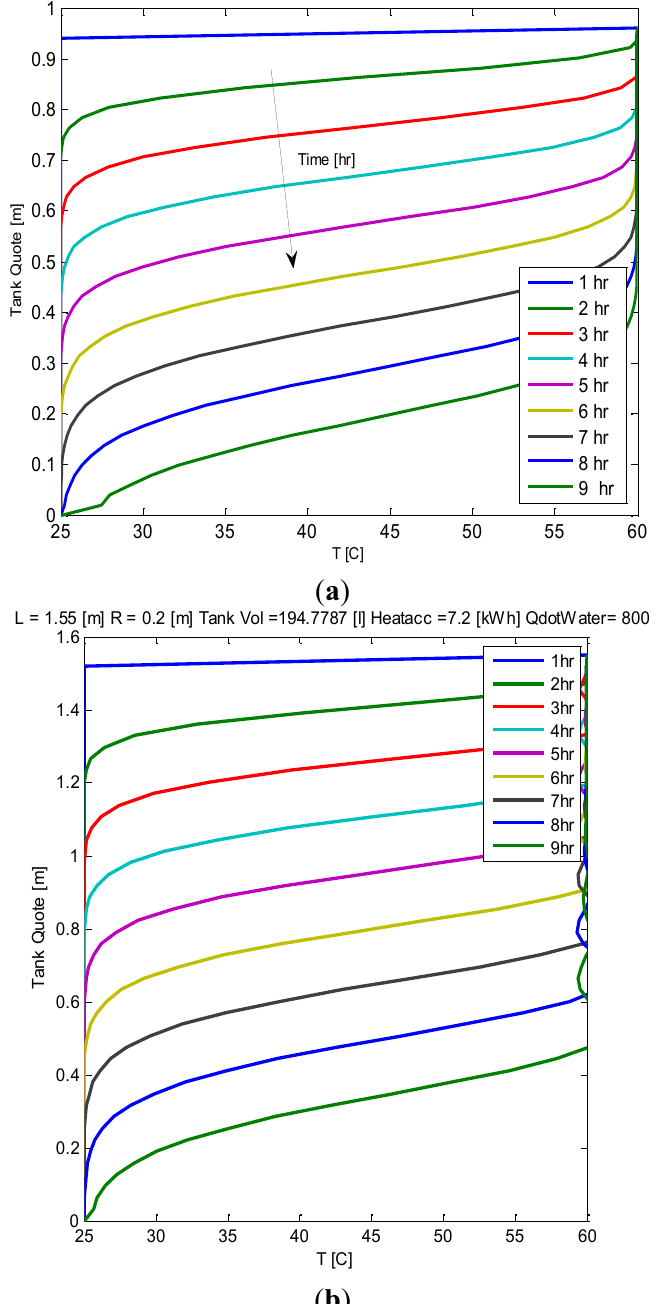
Figure 5. ( a ) Plot of temperature distribution inside the tank in the case of micro-CHP fuelled by natural gas; ( b ) Plot of temperature distribution inside the tank in the case of micro-CHP fuelled by